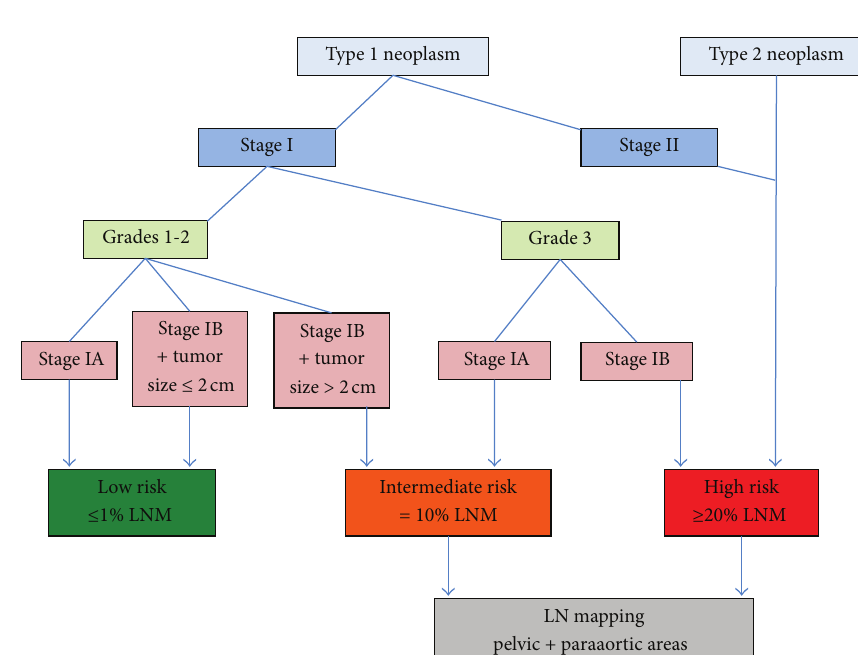
Figure 2: Indications of LN mapping integrating both Alhilli et al. and EMSO criteria (LNM: lymph node